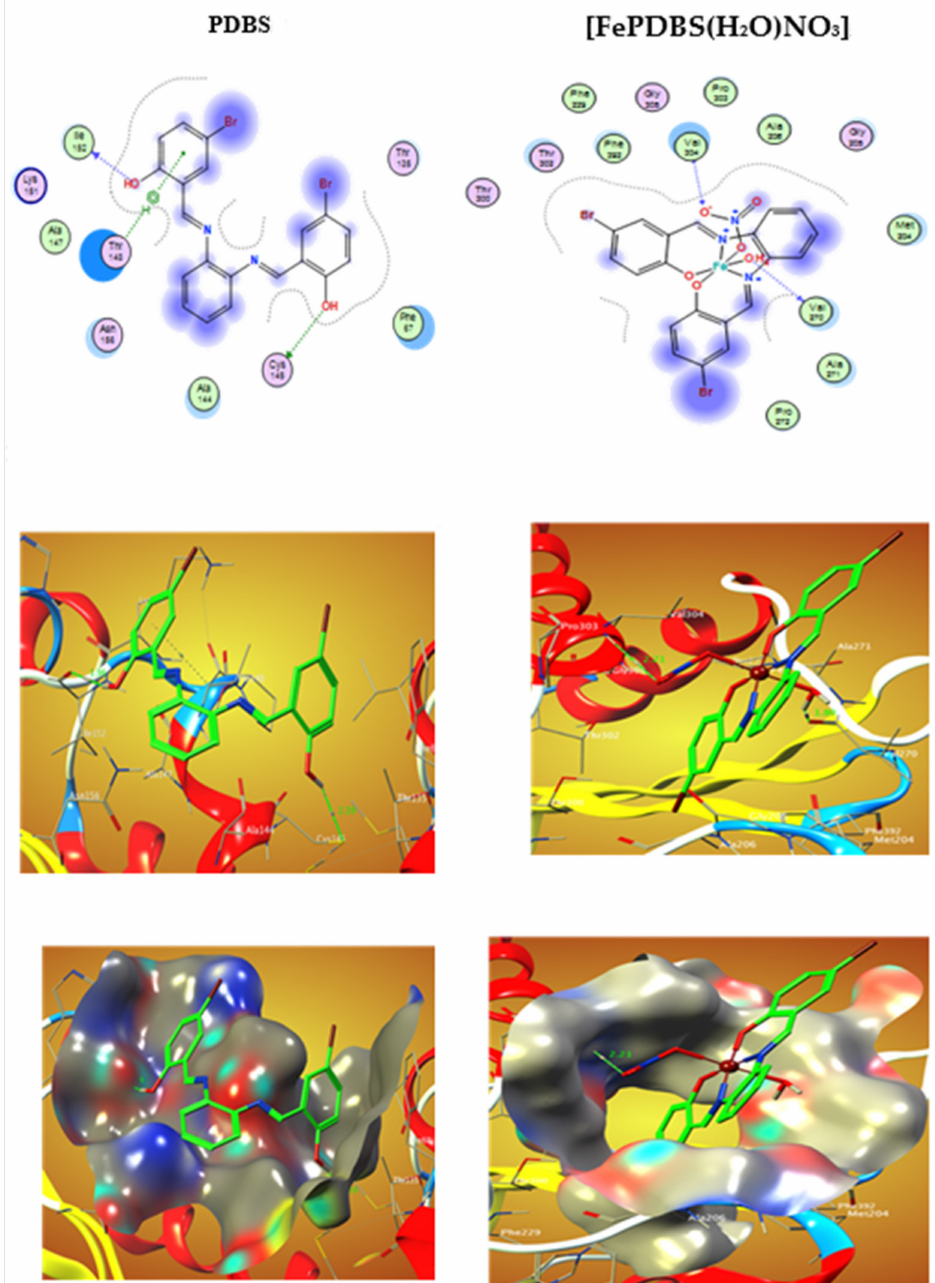
Figure 9. 2D and 3D plots of the interaction between PDBS and [FePDBS(H 2 O)NO 3 ] with the active site of the Escherichia coli protein receptor (PDB ID: 1fj4). Dotted curves depict hydrophobic interactions with amino acid